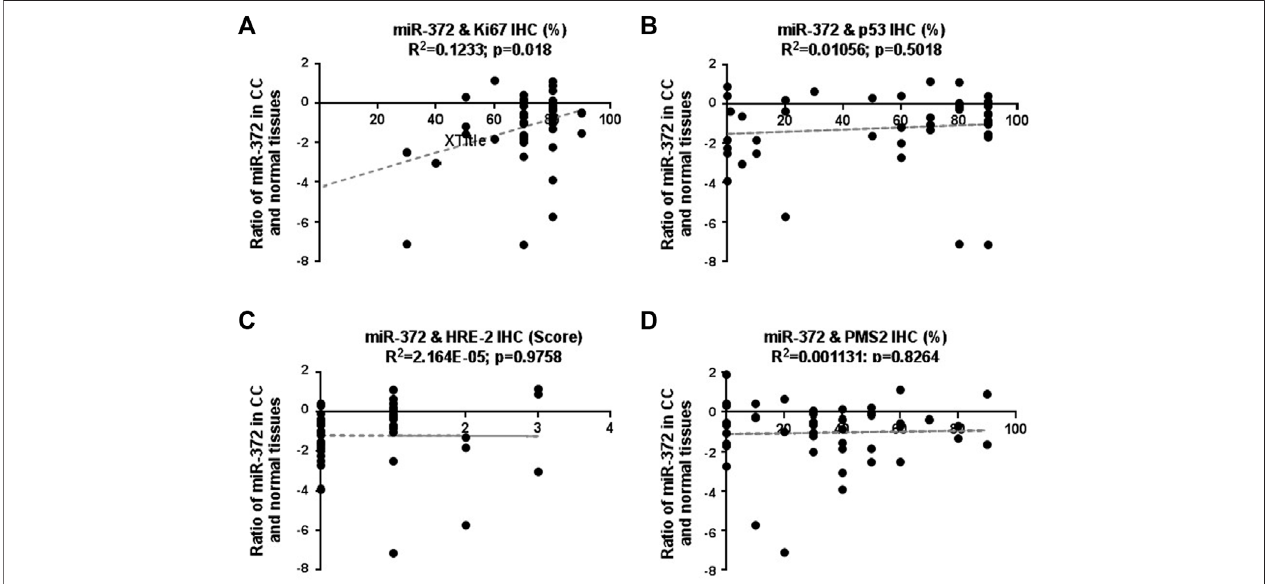
FIGURE 3 | Correlation between miR-372-3p expression and clinicopathological parameters, including Ki67, p53, HRE-2, MSHs, and PMS2, in colon cancer tissues. The Y-axis exhibits the log2 values of the ratio of miR-372-3p expression levels between colon cancer and matched normal tissues, and the X-axis exhibits the positivepercentagesofIHC stainingofKi67 (A) ,p53 (B) , HRE-2(scores) (C) ,MLHs/PMS2 (D) .ThecorrelationbetweenmiR-372-3pexpression and above parameters was statistically analyzed using the GraphPad Prism